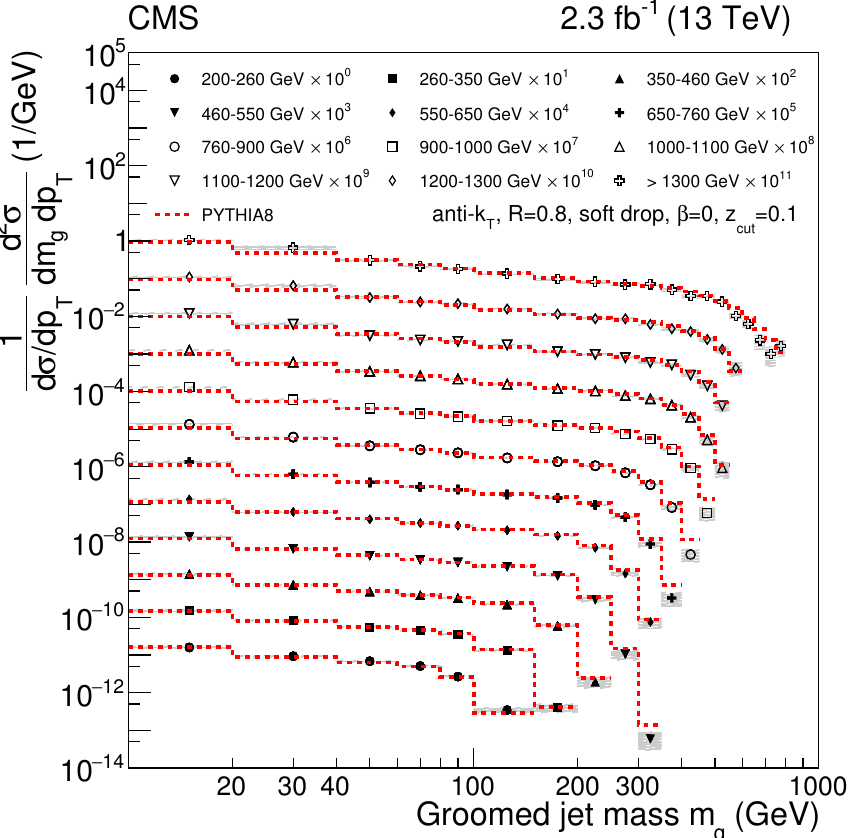
Figure 9 . Normalized cross section for groomed jets for all p T bins. Bins with statistical uncertainty larger than 60% are not shown. The data are shown with markers for each p T bin, scaled by a factor for better visibility. The total uncertainties (statistical added to systematic in quadrature) are shown with grey bands. The predictions from pythia 8 are shown as a dashed red